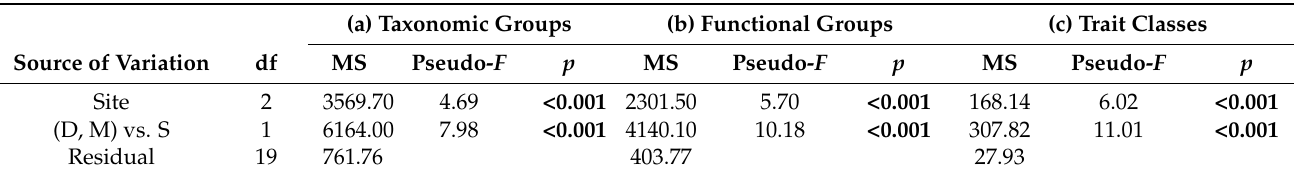
Table 3. PERMANOVAs testing the effects of site (Danum [D], Maliau [M], SAFE [S]) on multi-variate lichen community structure, in terms of (a) taxonomic and (b) functional groups, and (c) functional trait composition, in terms of trait classes, including planned comparisons between old growth (D, M) and logged (S) sites. Significant Monte Carlo p values are highlighted in bold.